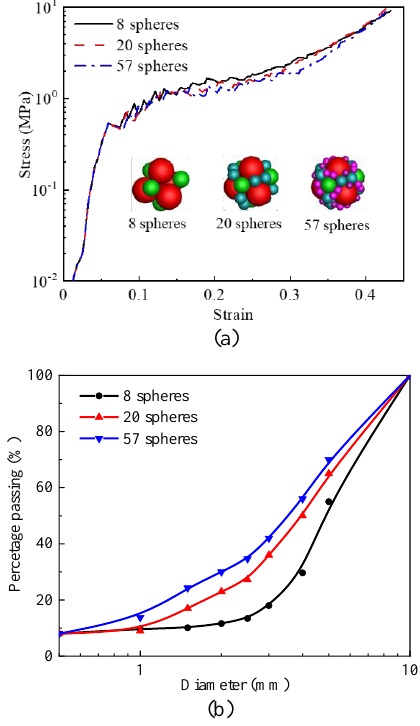
Fig. 1 . Effect of the number of fragments on (a) compaction curve; and (b) final PSD at 5 MPa. The inset shows the different generations of the Apollonian packing.